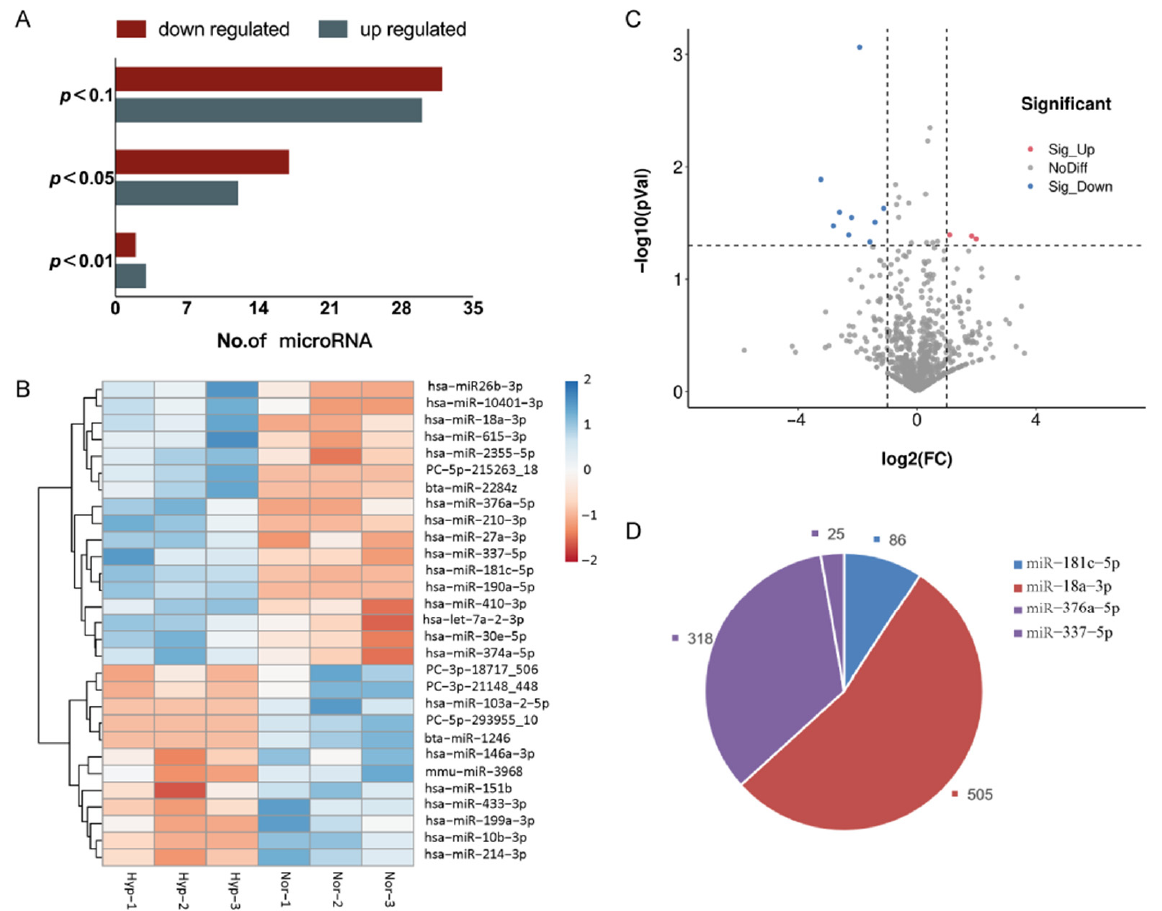
Figure 4. Hypoxia regulates miRNAs in BMSC-EVs. ( A ) The number of differentially expressed miRNAs. There were 29 differentially expressed miRNAs with a p -value < 0.05. ( B ) A heatmap of the 29 differentially expressed miRNAs. ( C ) Volcano plot displaying the 12 significant differentially expressed miRNAs based on the criteria of p < 0.05 and FC > 2 or <0.5. ( D ) Target gene prediction of 4 potential differentially expressed miRNAs. (913 possible target genes of these 4 miRNAs were predicted by using mirdb and TargetScan).